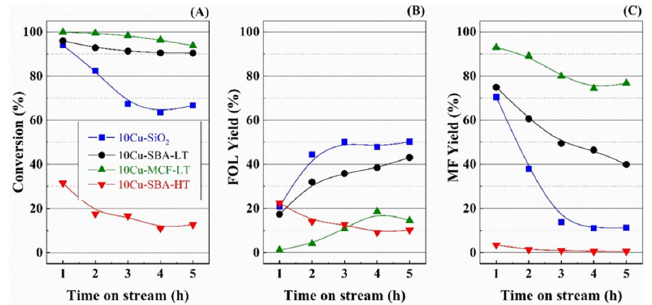
Figure 3. FUR conversion ( A ), FOL yield ( B ), and MF yield ( C ) in the FUR hydrogenation over